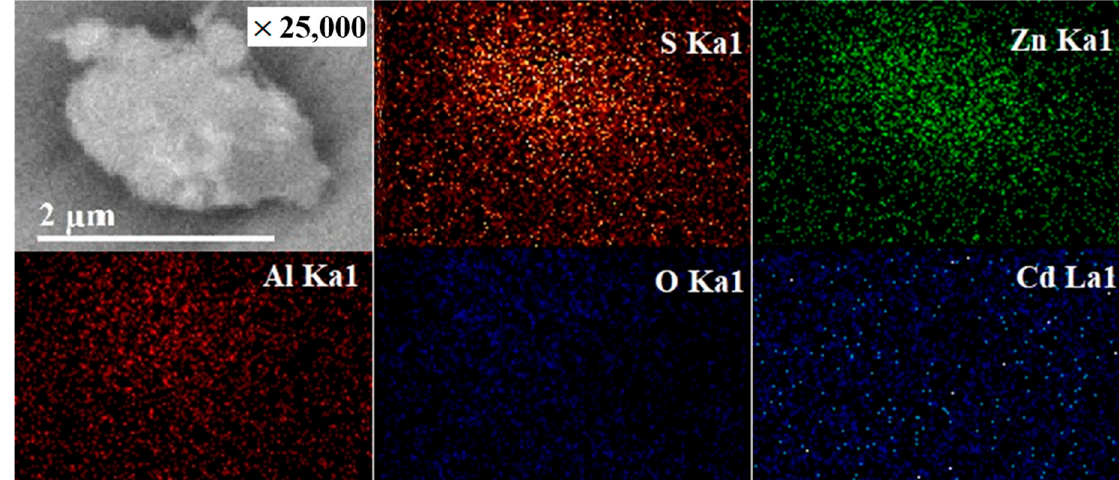
Figure 8. Energy dispersive spectroscopy mapping (EDS), including SEM image for the sample ZAC-100S.